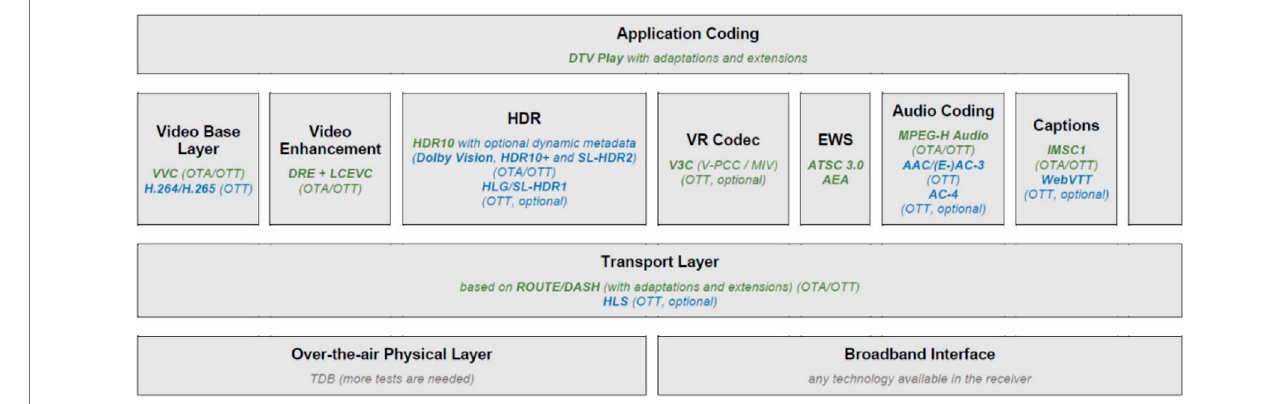
FIGURE 3 | Summary of the TV 3.0 adopted technologies